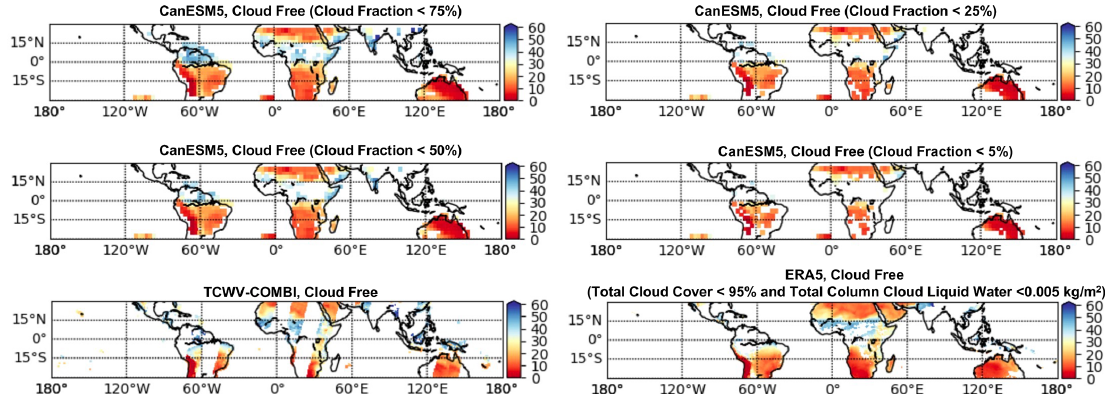
Figure 1. Examples of daily mean TCWV over tropical land obtained from CanESM5 with different cloud mask (pixels with cloud fraction larger than 75%, 50%, 25% and 5% at all pressure levels are considered clouded), along with data from TCWV-COMBI and ERA5 from 1 July